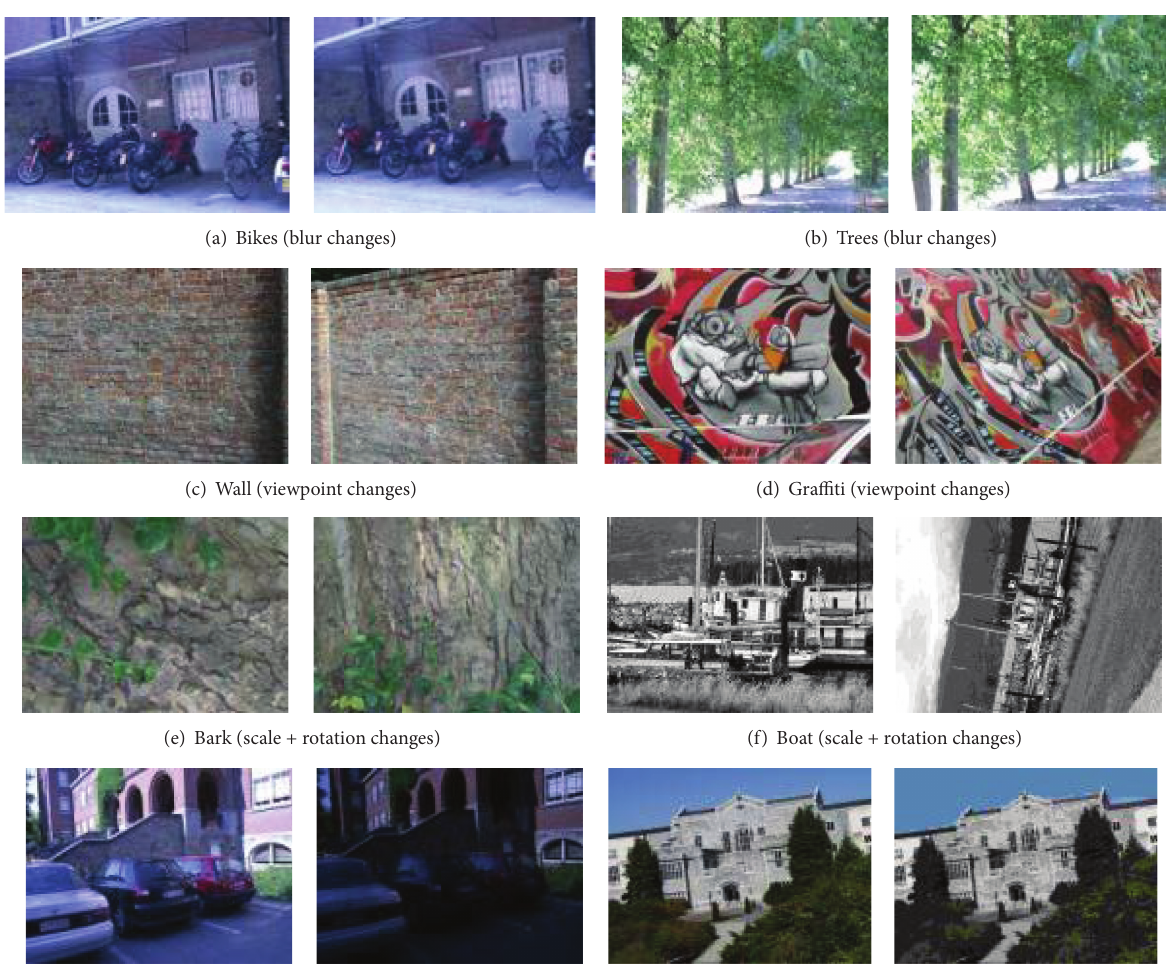
Figure 5: Testing image